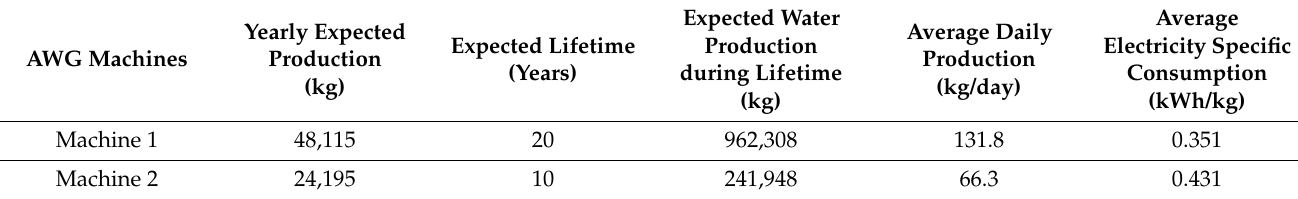
Table 3. Behaviour of AWG machines.